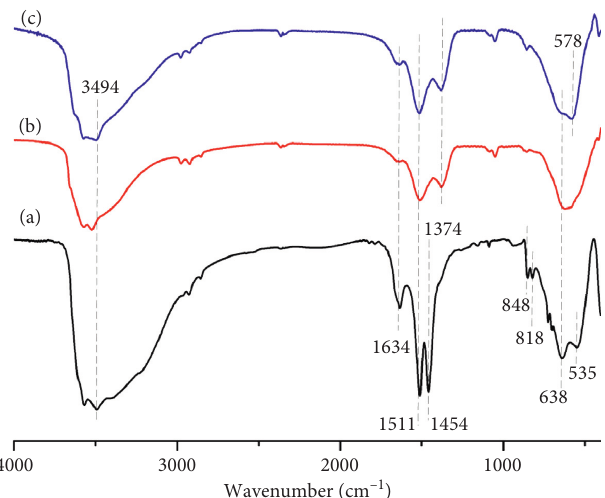
Figure 6: FTIR absorption patterns of (a) LEuH-Cl aggregates, (b) LEuH-flocs nanosheets, and (c) LEuH-flocs +fluoride ions.